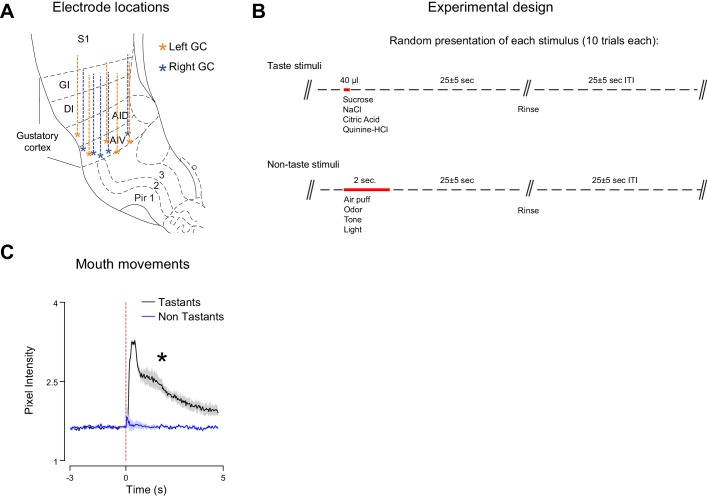
Electrodes placement and experimental design for the group of untrained rats.(A) Schematic representation of a coronal section of rat’s brain highlighting the dorso-ventral range of recording and electrodes placement in the gustatory cortex for the right (light blue) and left (light orange) hemisphere. (B) Schematic of the experimental design for each trial. Red bars highlight stimulus delivery. Each tastants is delivered through the IOCs in aliquots of 40 µl (duration of pulse: 25–30 ms) while each cross-modal stimuli is presented for 2 s. (C) Average mouth movements evoked by tastants (black) and by cross-modal stimuli (blue). Red dotted line indicates stimulus onset. Asterisk indicates p<0.05 Wilcoxon Test.